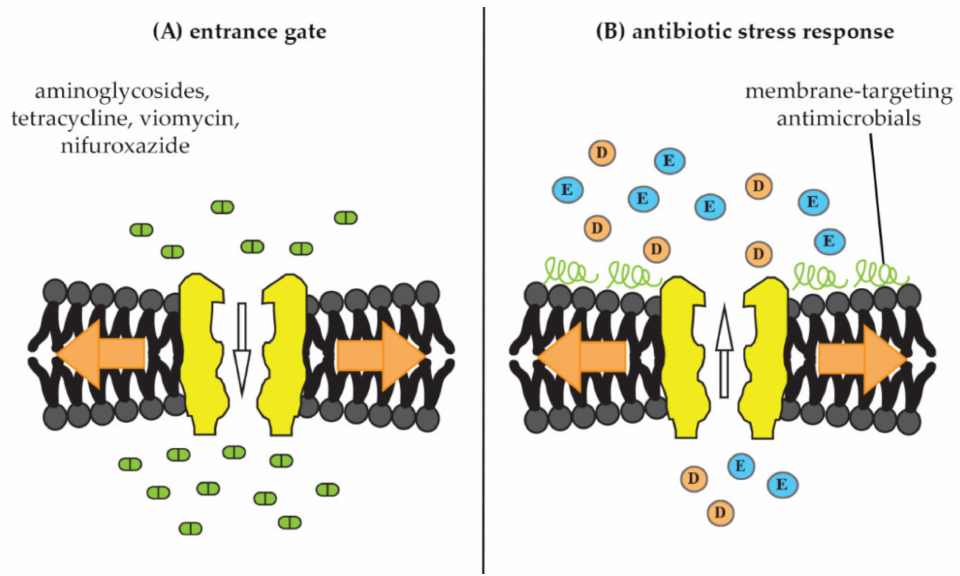
Figure 4. Documented interactions of mechanosensitive channels with antimicrobials. ( A ) Mechanosensi- tive channels as entrance gate for antimicrobials into bacterial cells. Upon membrane stretch (orange arrows), channels open and allow better uptake of certain antibiotic molecules, such as the aminogly- cosides dihydrostreptomycin, spectinomycin, and kanamycin as well as tetracycline, viomycin, and nifuroxazide [19,20]. ( B ) Mechanosensitive channels as part of an antibiotic-stress response. Treat- ment with membrane-active antimicrobials, such as MP196, nisin, gramicidins, and aureins mimics membrane stretch and triggers release of osmoprotective amino acids (E = glutamate, D = aspartate), resulting in osmotic-membrane stabilization and decreased antibiotic susceptibility